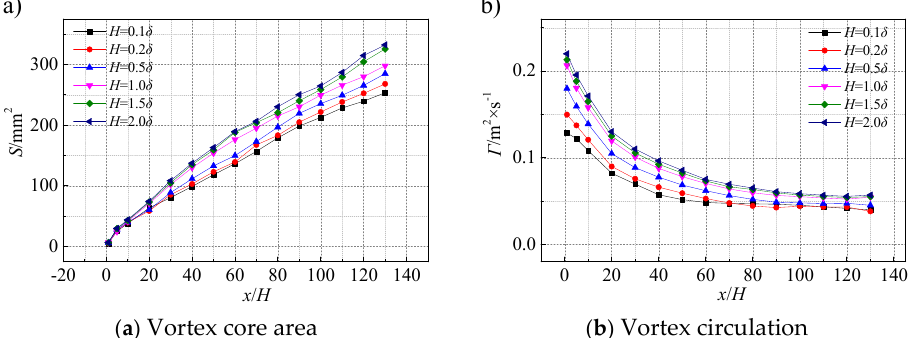
Figure 12. Distribution of vortex core area and vortex circulation with flow direction.